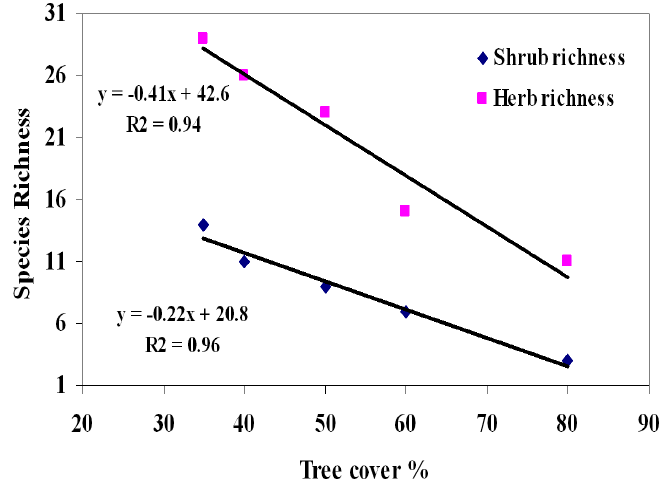
Fig. 1. Relationship between forest types, 1. Rhododendron arboreum mixed forest (RMF); 2. Quercus leucotrichophora for- est (QLF) and 3. Q. semecarpifolia mixed forest (QSF) and tree crown cover of three forest types of KWLS, Central Himalaya, India